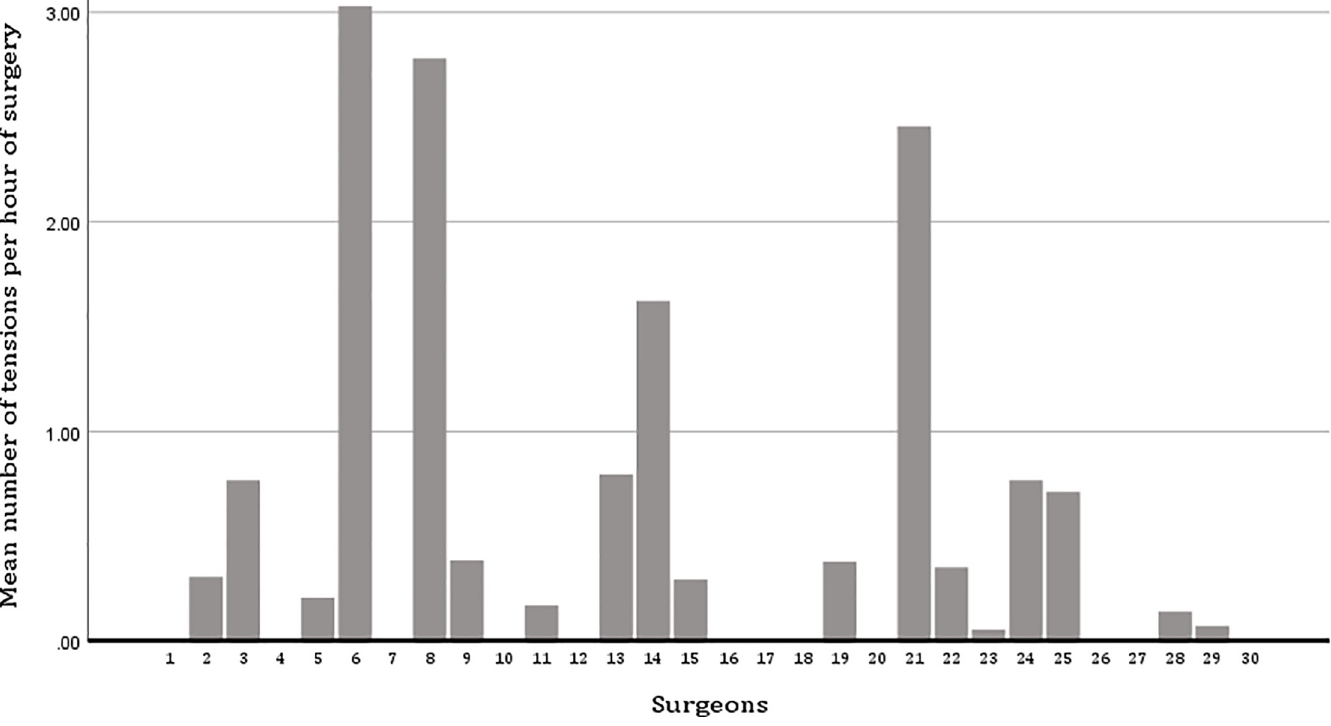
Fig 1. Mean tensions per hour across all 30 participating